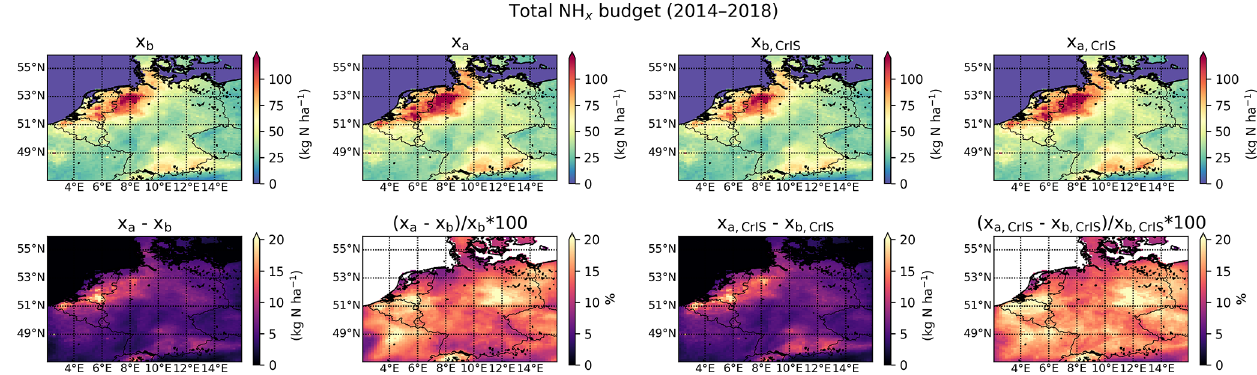
Figure 10. The total NH x budget from 2014–2018 in the background ( x b and x b , CrIS ) and analysis ( x a and x a , CrIS ) model runs in LOTOS- EUROS, as well as their absolute and relative difference.